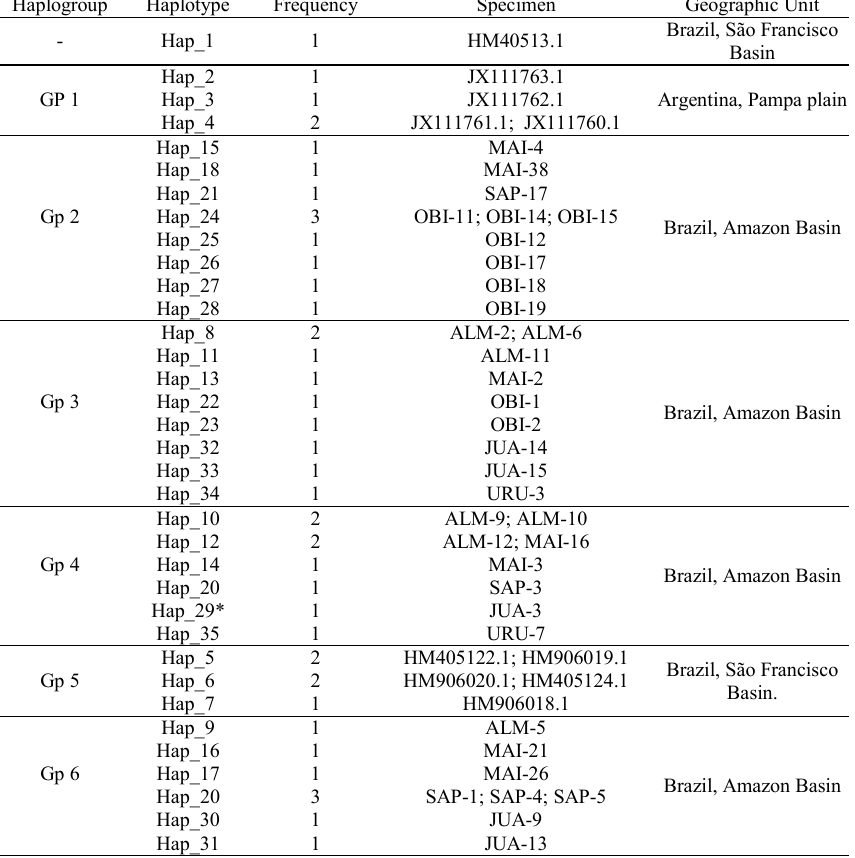
Table 3. Citochrome Oxidase I (COI) haplotypes of Hoplias malabaricus , except Hap_1 that is Hoplias intermedius . *Haplotype not included for distance estimation (see text for